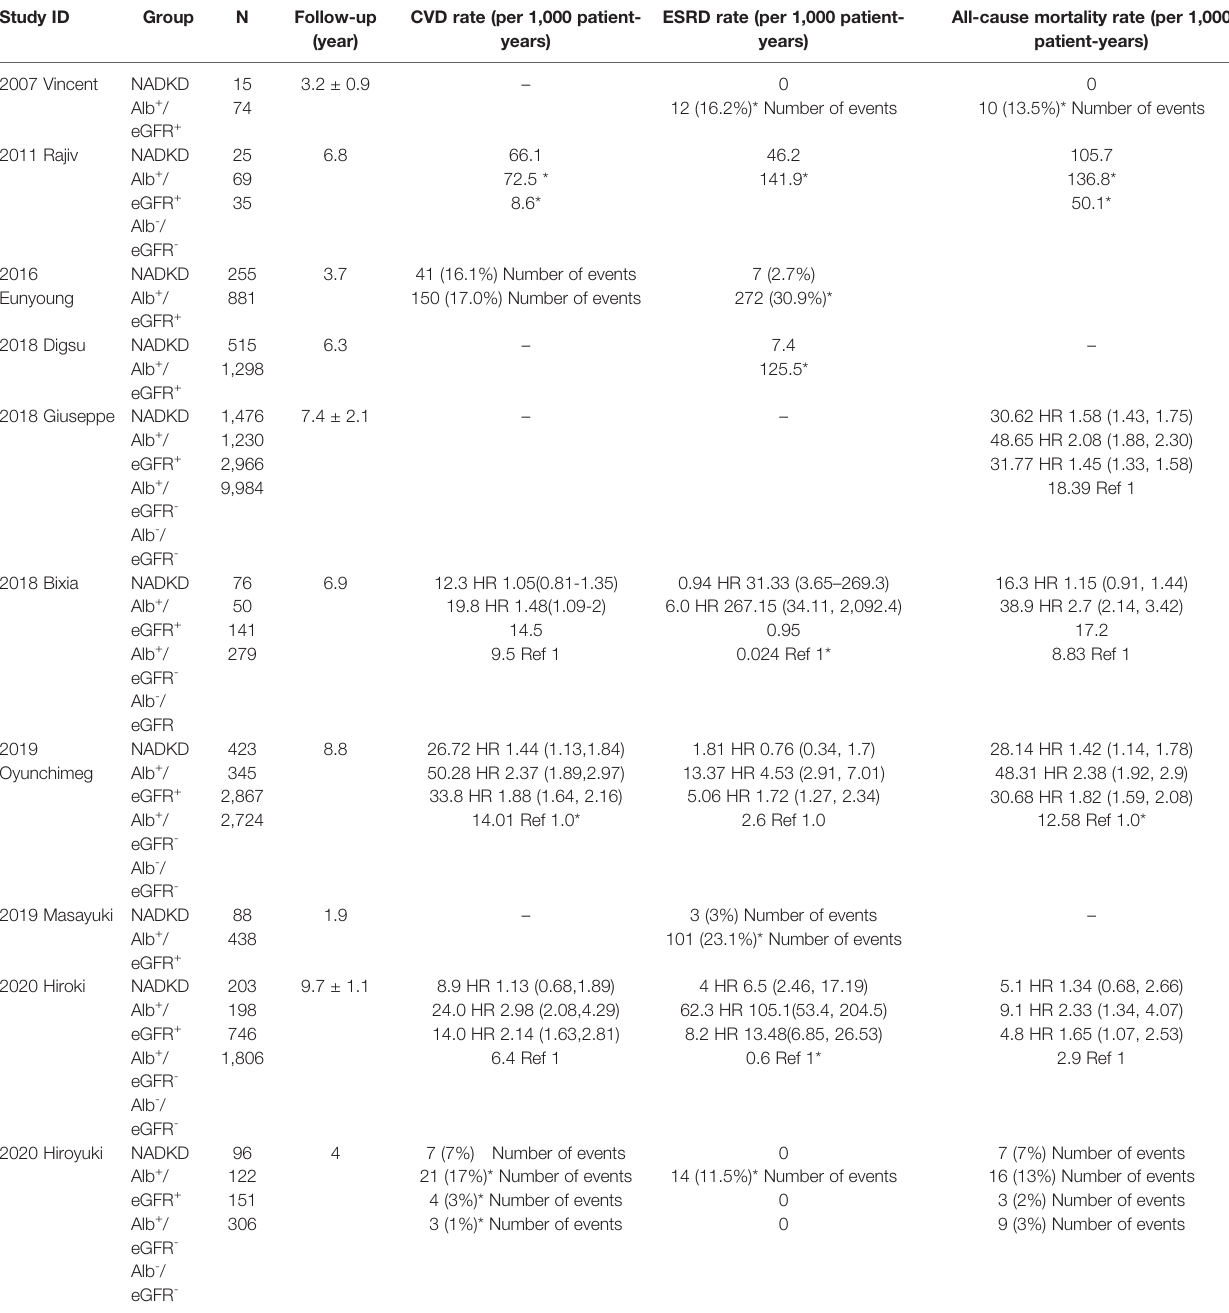
TABLE 3 | Long-term outcomes of patients with type 2 diabetes and non-albuminuric diabetic kidney disease. Study